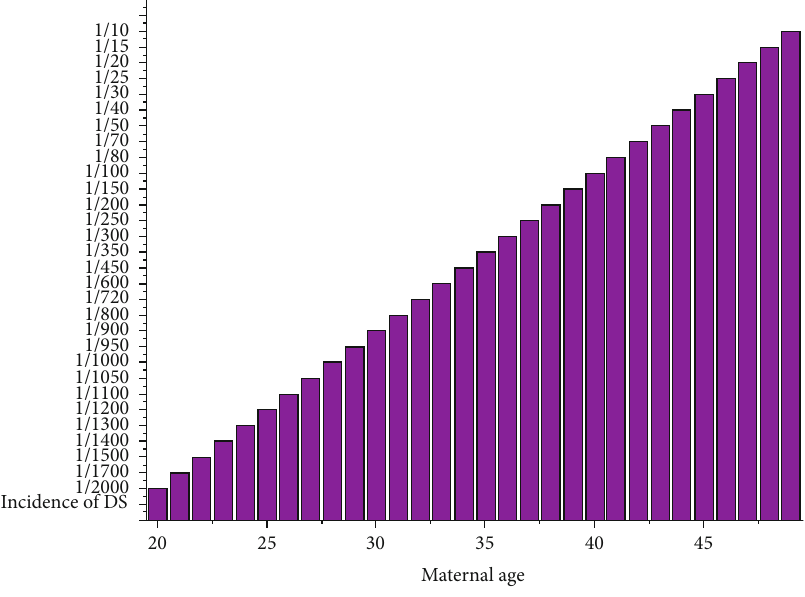
Figure 3: Incidence of Down syndrome in relation to maternal age. Table 2: Diagnosis and di ff erential diagnosis of obstructive sleep apnea in children. S.